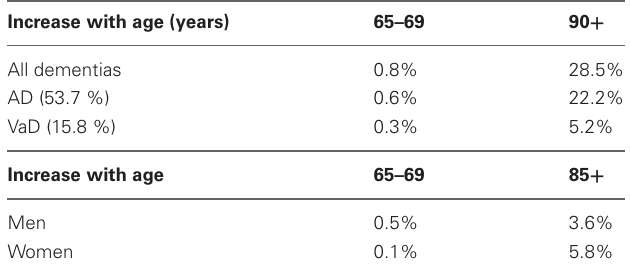
Table 2 | Prevalence of VaD (clinical data) [from Jellinger